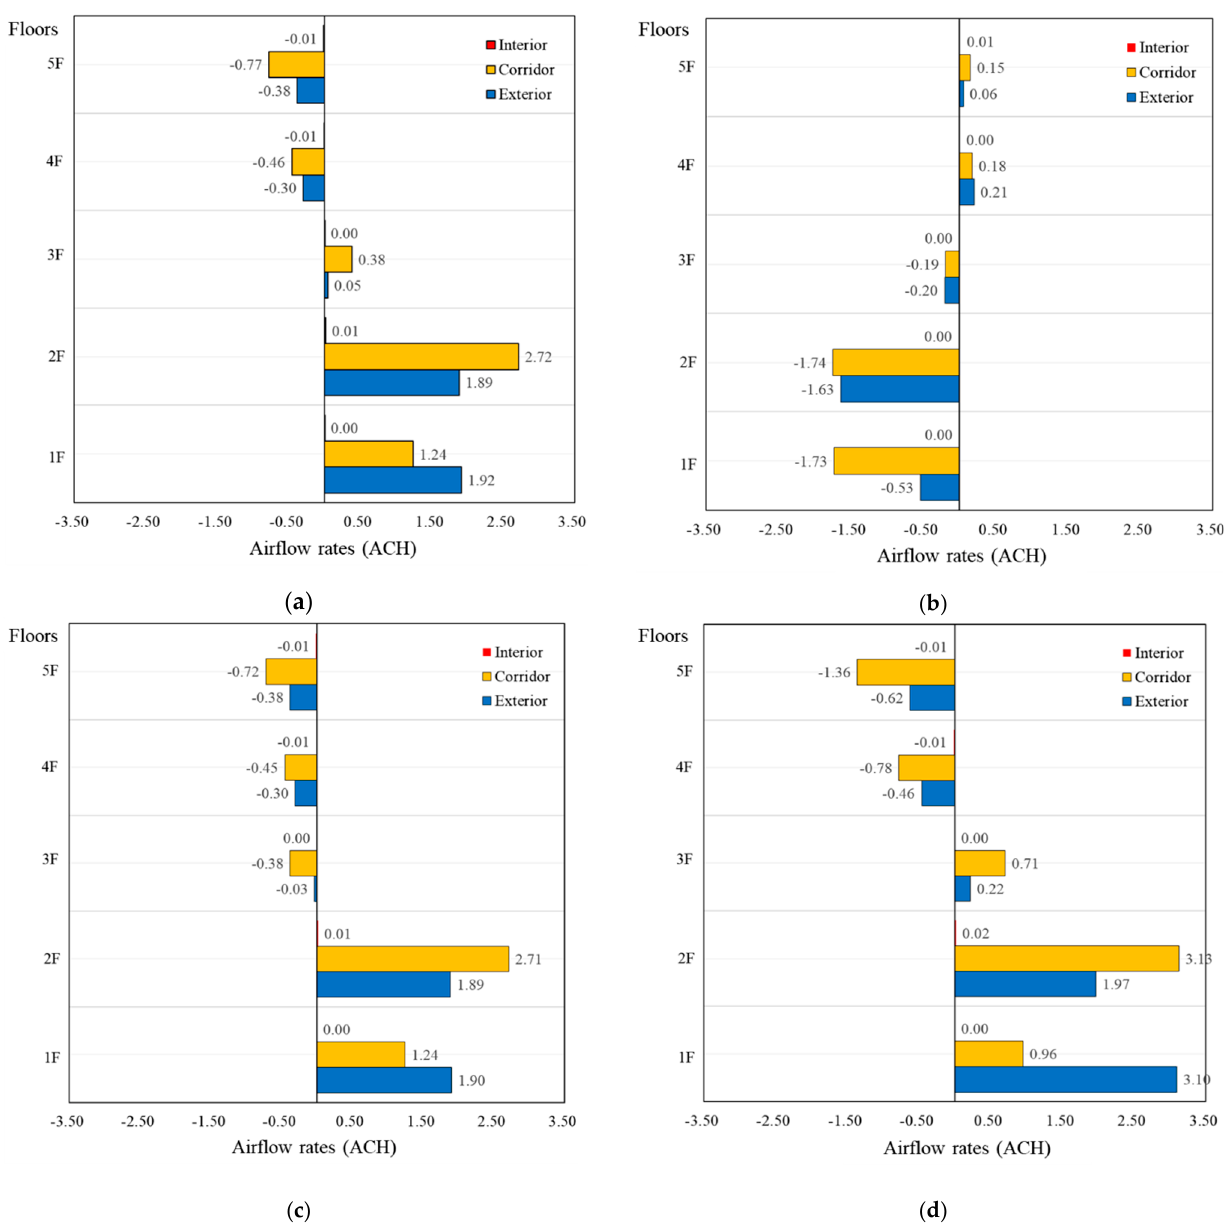
Figure 8. Airflow rates in the reference building: ( a ) case 1, spring; ( b ) case 2, summer; ( c ) case 3, autumn; ( d ) case 4, winter.